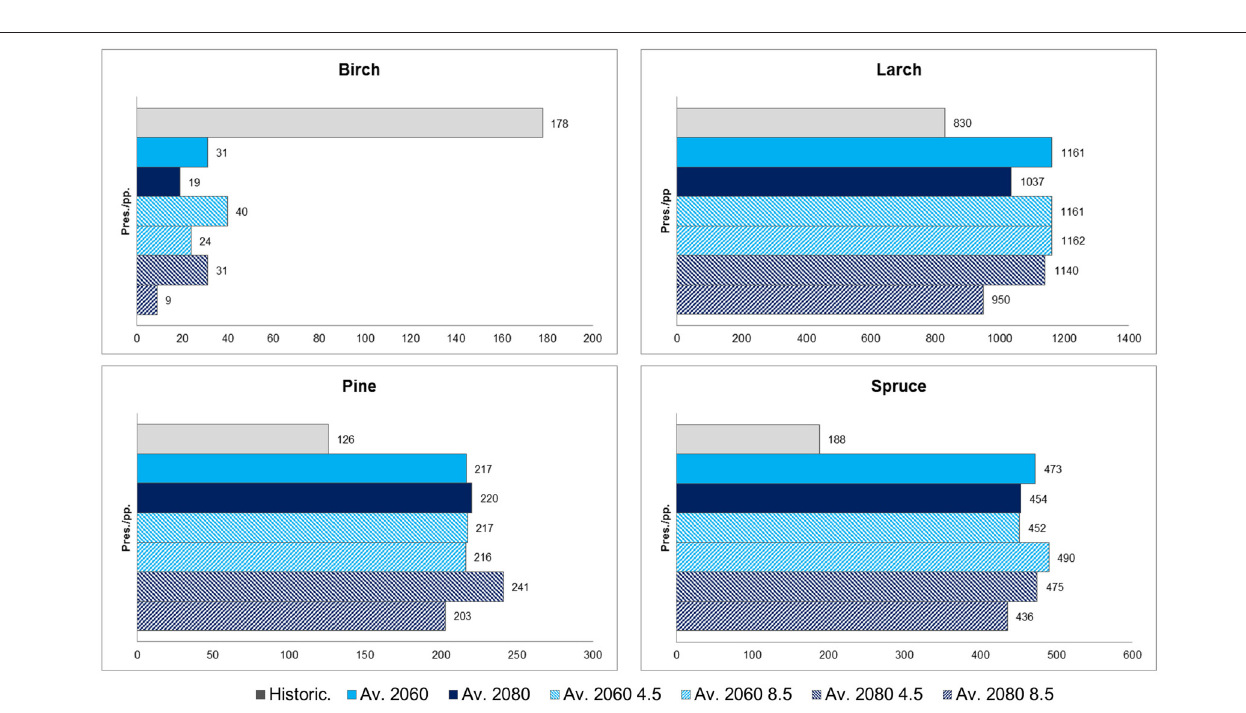
FIGURE 8 | Historical presence (pres.) compared to the average of projected presences (pp.) (averaged and not between RCPs for 2060 and 2080) for the Arctic Circle